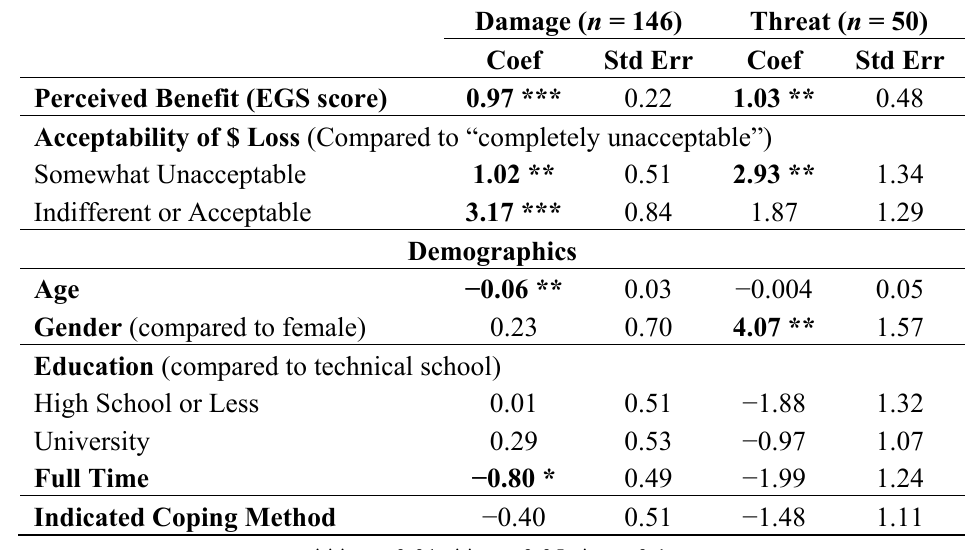
Table 6. Influence of independent variables on the overall acceptability of species, by type of